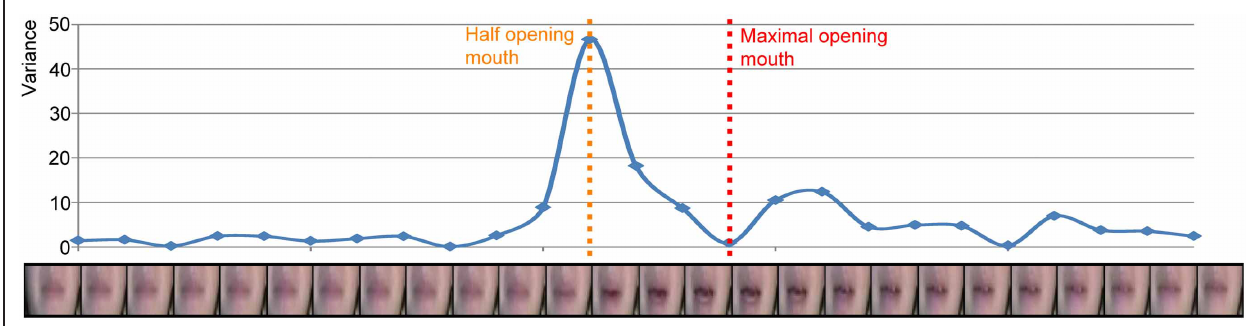
right of the dot). The orange dotted line represents the half opening of the mouth and the red dotted line represents the maximal opening of the